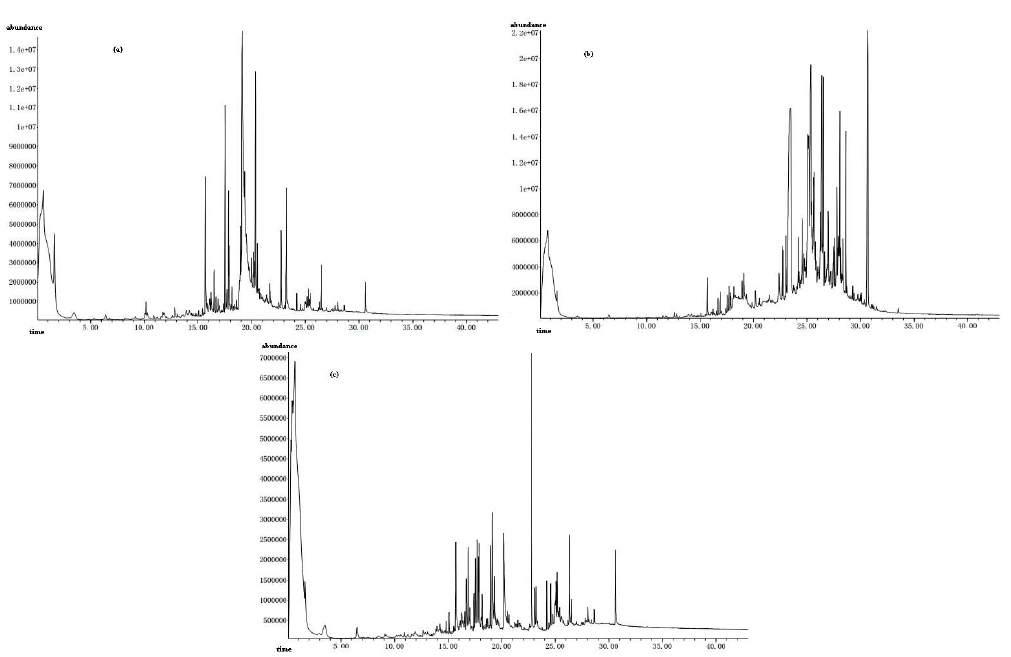
Figure 1. The total ion chromatogram of constituents after online pyrolytic methylation at 423 °C for GBL before ( a ) and after EBUE ( b ) as well as after Soxhlet extraction ( c ).